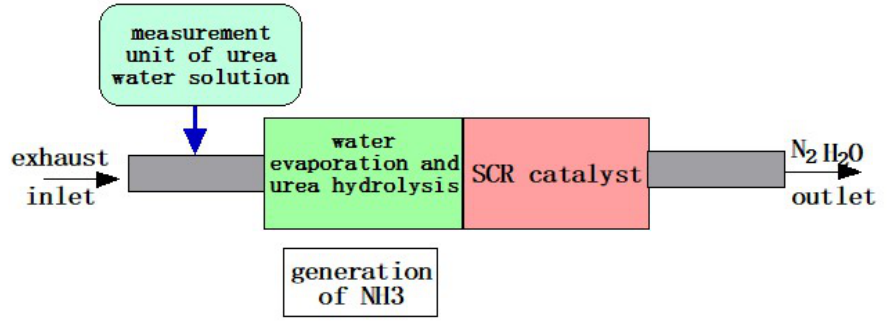
Fig. 1 Diagram of the principle of SCR